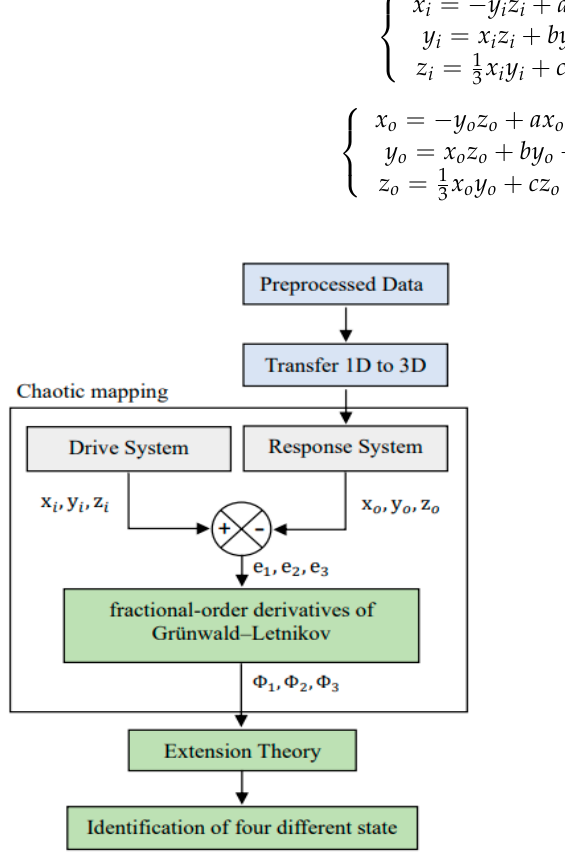
Figure 2. The procedure for converting original data into dynamic errors via chaotic mapping for ball bearing condition identi fi cation.